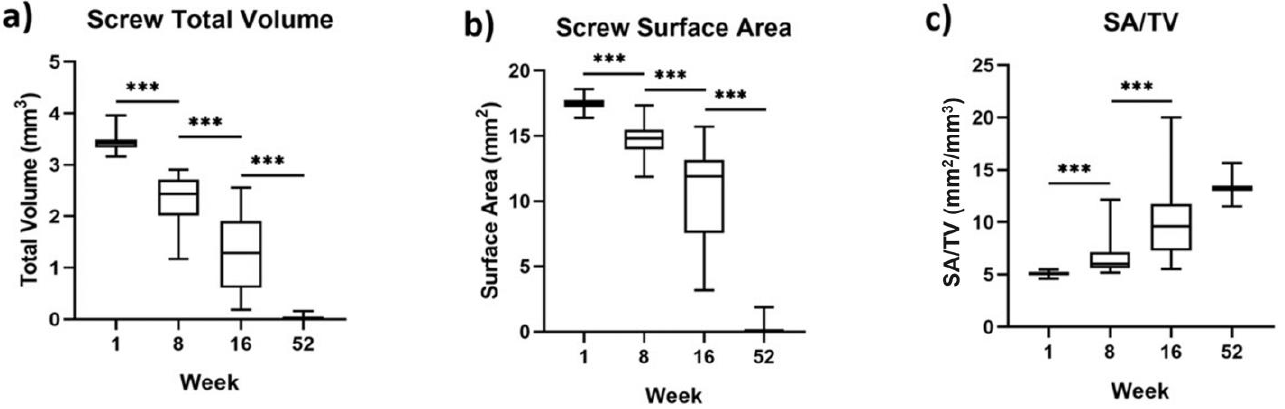
Figure 5. Box and whisker diagrams for the magnesium screw: ( a ) total volume, ( b ) surface area, and ( c ) the ratio of surface area/ total volume, after implantation in a GBR setting in beagle dogs. The whiskers indicate the range of data. p values are represented on the figures as follows: p < 0.001: ***.